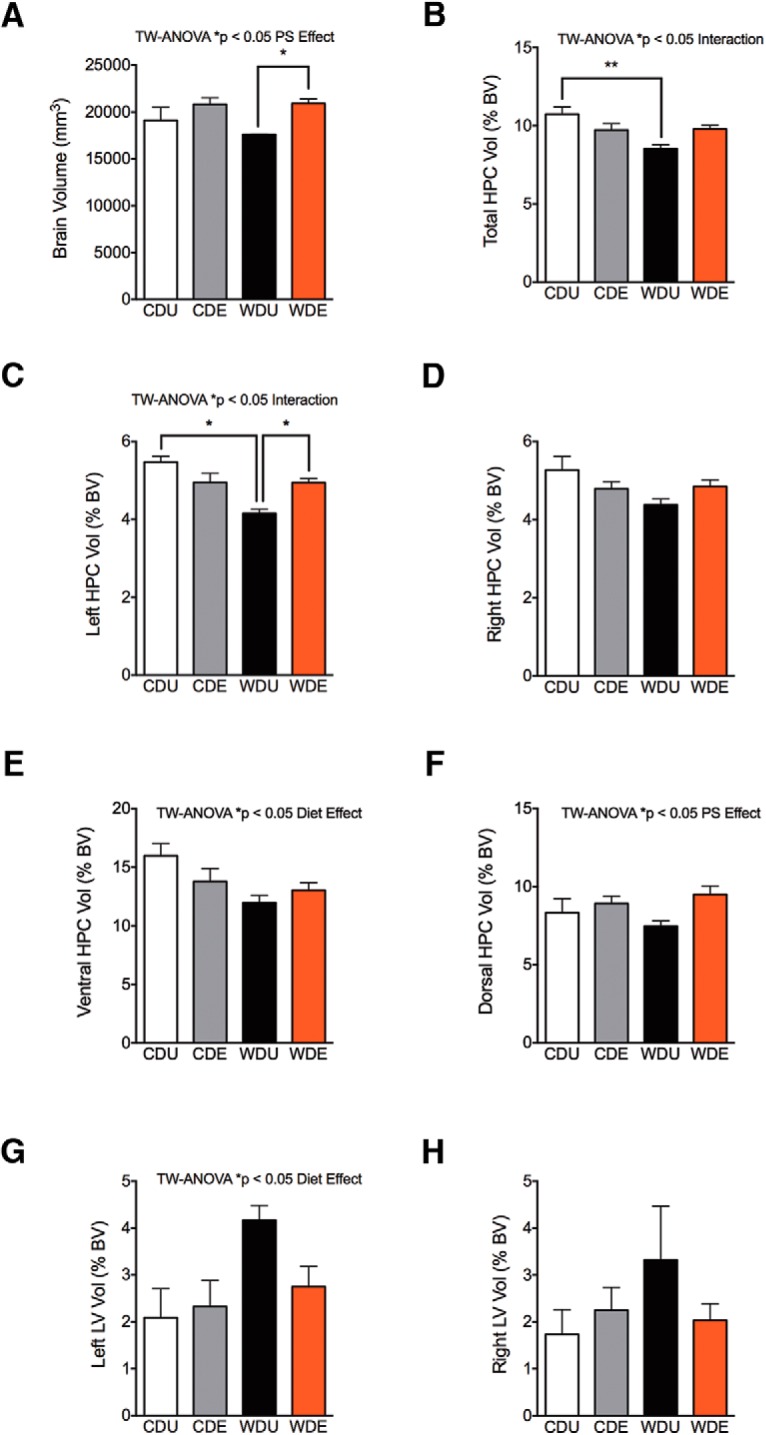
WD and traumatic stress exposure alter hippocampal volume in a region-specific manner. A, We found a significant main effect of PS on total brain volume (F(1,11) = 11.31, p = 0.0063). Post hoc comparisons indicated that PS exposure increased the brain volume in WDE rats when compared with CDU rats (p = 0.036). TW-ANOVA revealed no significant main diet effects (F(1,11) = 0.91, p = 0.36) or interactions (F(1,11) = 1.13, p = 0.31) on total brain volume. B, WDU rats showed reduced HPC volumes when compared with CDU rats (diet effect: F(1,11) = 9.59, p = 0.010; post hoc test, p = 0.0080). Although analyses revealed no significant main PS effects (F(1,11) = 0.13, p = 0.73), we found a significant interaction between diet and PS exposure (F(1,11) = 10.62, p = 0.0076) on total brain volume. C, The left HPC volume was significantly affected by the diet (F(1,11) = 7.34, p = 0.020) and PS exposure (F(1,11) = 5.88, p = 0.034). Post hoc comparisons revealed reduced HPC volumes in WDU rats when compared with CDU rats (WDU vs CDU, p = 0.022) and WDE rats (WDU vs WDE, p = 0.015). We also found significant interactions between the diet and PS exposure (F(1,11) = 7.38, p = 0.020). D, The diet type (F(1,11) = 3.74, p = 0.079) and PS exposure (F(1,11) = 0.00091, p = 0.98) did not have a significant effect on right HPC volumes (interaction: F(1,11) = 4.83, p = 0.050). E, We found reduced ventral HPC volumes in the rats that consumed the WD (F(1,11) = 6.93; p = 0.023). We found no significant main effects of PS exposure (F(1,11) = 0.39, p = 0.54) or interactions (F(1,11) = 3.27, p = 0.098) on ventral HPC volumes. F, Interestingly, PS exposure led to increased dorsal HPC volumes (F(1,11) = 7.45; p = 0.020). We found no significant main effects of the diet type (F(1,11) = 0.19, p = 0.67) or significant interactions between diet and PS exposure (F(1,11) = 1.23, p = 0.29). G, The WD had a significant effect on increasing the left lateral ventricle volume (F(1,11) = 5.95; p = 0.033). We found no significant main effects of PS exposure (F(1,11) = 1.33, p = 0.27) or interactions (F(1,11) = 2.59, p = 0.14). H, We found no significant main effects of diet (F(1,11) = 1.23, p = 0.29), PS exposure (F(1,11) = 0.39, p = 0.54), or interactions (F(1,11) = 2.13, p = 0.17) on the right lateral ventricular volume. *p < 0.05, **p < 0.01; n = 3–5 brains/group. BV, Brain volume; LV, lateral ventricle.